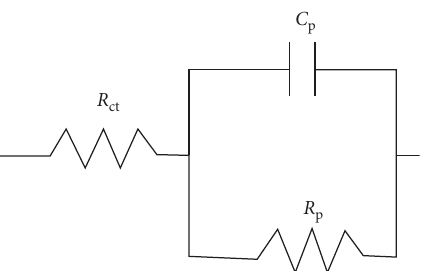
Figure 14: (a) Nyquist plot. (b) Bode plot of mild steel in a stagnant naturally aerated solution of 1 M H PSA at 25 °